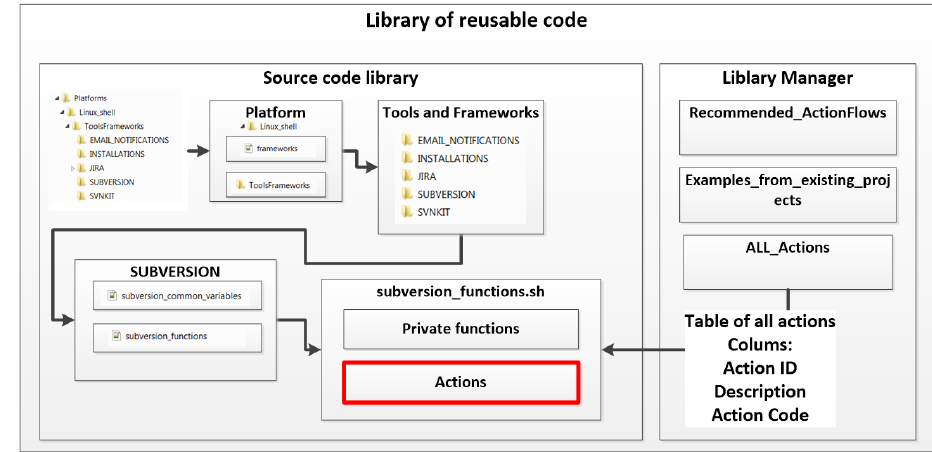
Fig. 5. Structure of library of reusable source code.